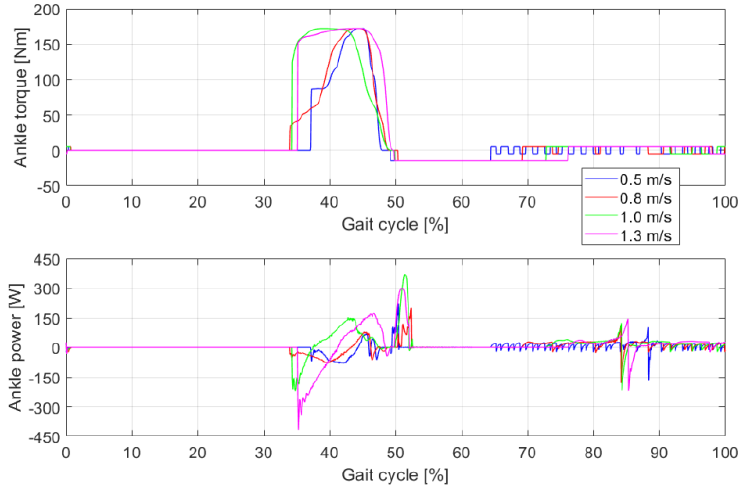
Figure 9. Ankle torque and power during one gait cycle at different walking speeds.